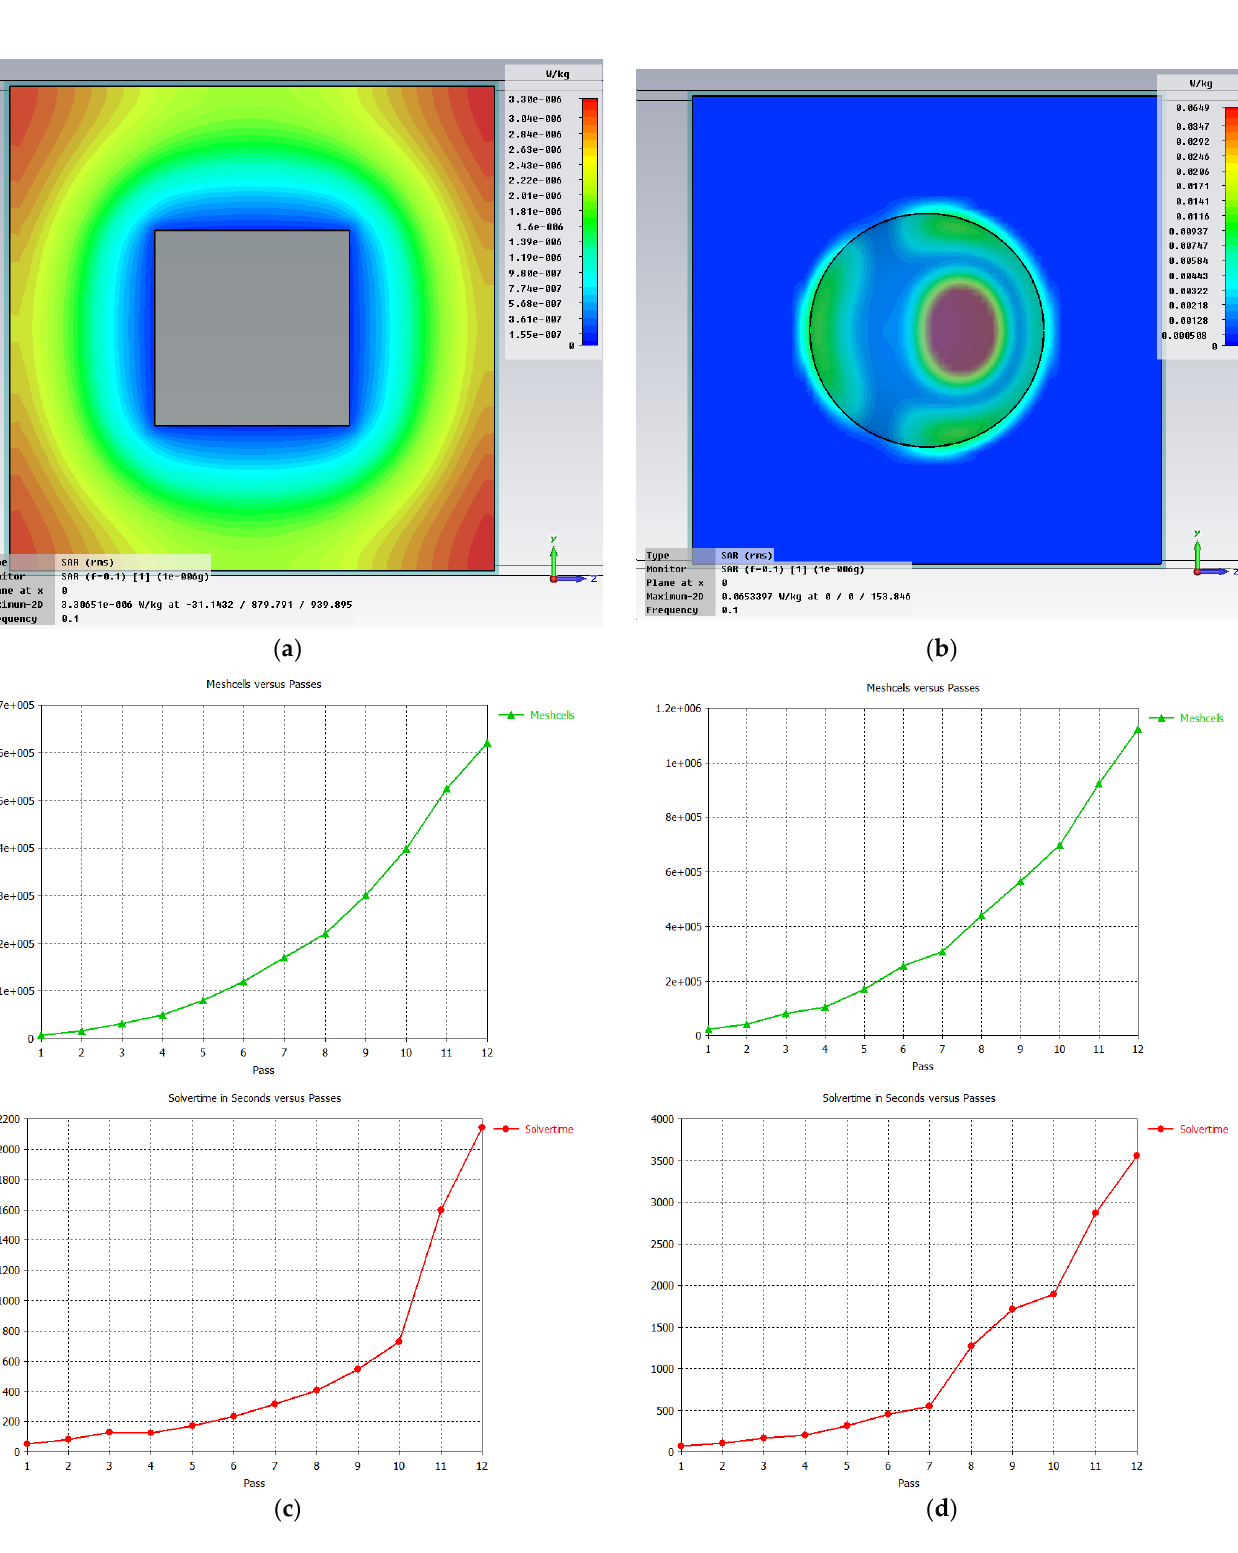
Figure 3. Cubical and spherical particles compared: ( a ) cubical metallic (Fe) particle inside LDPE—simulation conditions and SAR evolution at 0.1 GHz; ( b ) spherical dielectric (TiO 2 ) inside LDPE—simulation conditions and SAR evolution at 0.1 GHz; ( c ) number of cells and calculation time required for cubic inserts; ( d ) number of cells and calculation time required for spherical inserts.